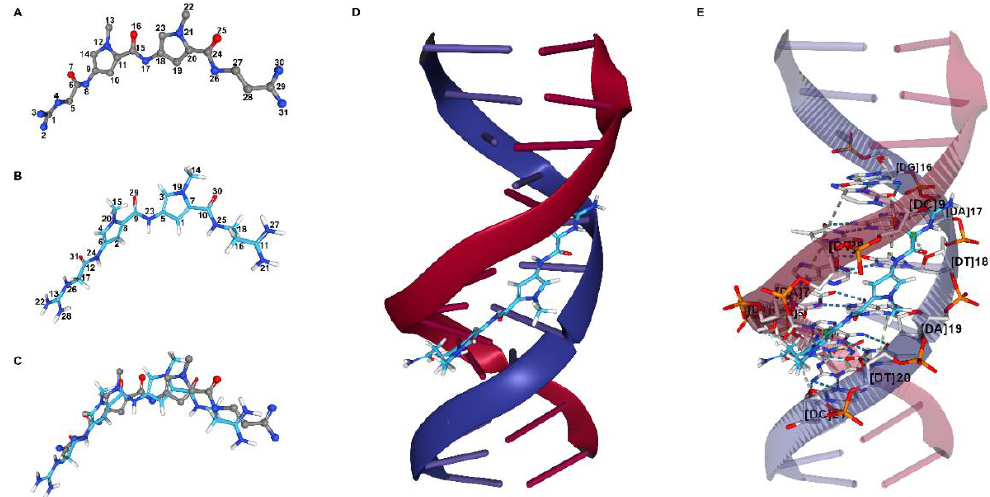
Figure 3. Analysis of re-docking results regarding the minor groove-binding drug netropsin and the DNA dodecamer d(CGCGATATCGCG). Experimental pose of the ligand in ball and stick representation, with carbon, nitrogen, and oxygen atoms coloured grey, blue, and red, respectively. Docked pose of the ligand in liquorice representation, with carbon, nitrogen, oxygen, and hydrogen atoms coloured light blue, blue, red, and white, respectively. DNA stands are in cartoon representation, while the nitrogenous bases are in base representation, with atom index colour style. ( A ) Atom indexes of the experimental pose of netropsin. ( B ) Atom indexes of the docked pose of netropsin assigned by OpenEye HYBRID docking program. ( C ) Netropsin docked pose compared with experimental pose. ( D ) Netropsin docked pose within the DNA minor groove. ( E ) Interactions between the DNA dodecamer and netropsin in the docked pose. Selected residues from the receptor are in liquorice representation, with carbon, oxygen, nitrogen, and phosphorus atoms coloured light grey, red, blue, and orange, respectively. These residues are labelled in black, and selected interactions are shown as dashed lines. Netropsin atoms involved in the main interactions are surrounded by a green sphere. The receptor cartoon representation has been opacified for clarity.